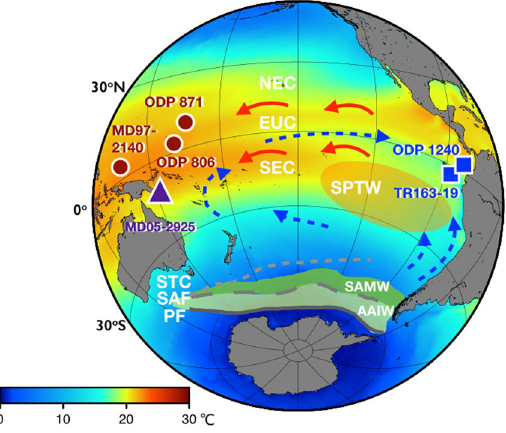
Figure 1. A sea surface temperature map with site locations, schematic circulation, and distribution of water masses. The purple triangle represents site MD05-2925. Dark red circles and blue squares are the selected sites in the equatorial Pacific. Gray solid, long dashed, and short dashed lines show the Polar Front (PF), Subantarctic Front (SAF), and Subtropical convergence zone (STC), respectively. Gray and green shadings denote the formation regions of Antarctic Intermediate Water (AAIW) and Subantarctic Mode Water (SAMW), respectively. Light orange shading represents the South Pacific Tropical Water (SPTW). Blue dashed arrays represent the undercurrent pathways of the Equatorial Under Current (EUC and water masses from southern ocean). Red solid arrows represent the surface South Equatorial Current (SEC) and North Equatorial Current (NEC). The AAIW and SAMW (gray and green shadings) flow from the southern hemisphere high latitudes to the SPTW region and spread out to the South Pacific Ocean through the EUC and EEP wind-driven upwelling system and resurfacing processes through water mass mixing on the scale of decades 20 . This map was generated with Generic Mapping Tools (GMT) version 5 (ref. 40). Global satellite mean annual sea surface temperatures during 2009–2013 with color coding are from the National Aeronautics and Space Administration (NASA) Ocean Color database (http://oceancolor.gsfc.nasa.gov) 41